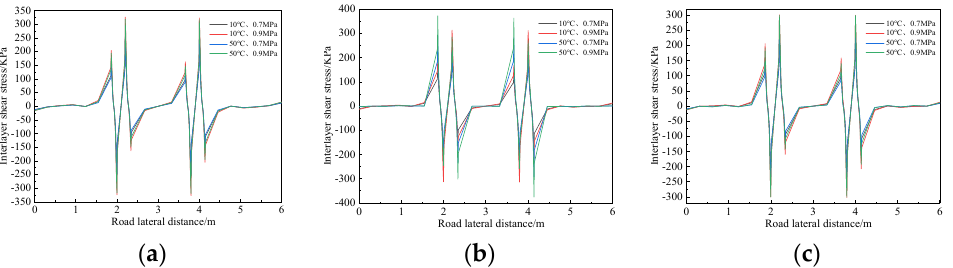
Figure 13. Shear stress distribution at the bottom of the upper layer. ( a ) Structure-I. ( b ) Structure-II. ( c ) Structure-III.